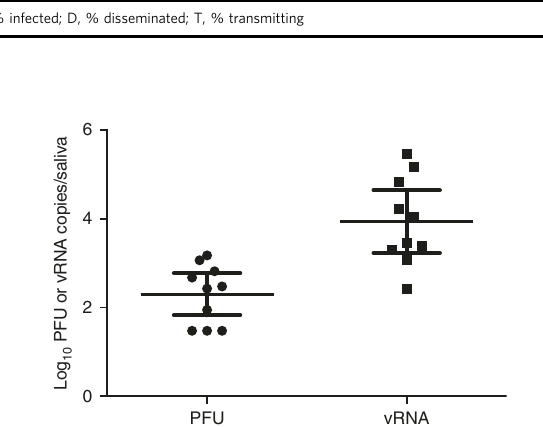
Fig. 2 Viral titers and RNA loads in saliva of Aedes aegypti used to challenge macaques with ZIKV. Mosquitoes were allowed to feed on ZIKV-infected mice. Twelve days later, mosquitoes were exposed to naive macaques.